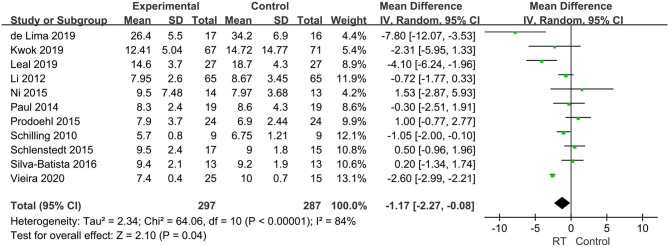
Forest plots of the effects of lower limb RT on gait performance—timed-up-and-go-test in PD. CI, confidence interval.